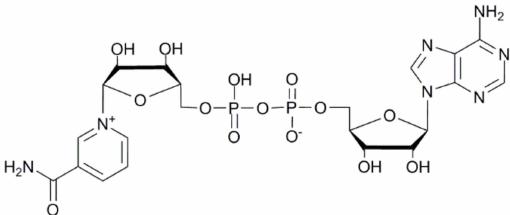
Figure 1. The structure of the beta-oxidized nicotinamide adenine dinucleotide (NAD + )-molecule. Natural and modified nucleosides and their phosphorylated derivatives are indispensable